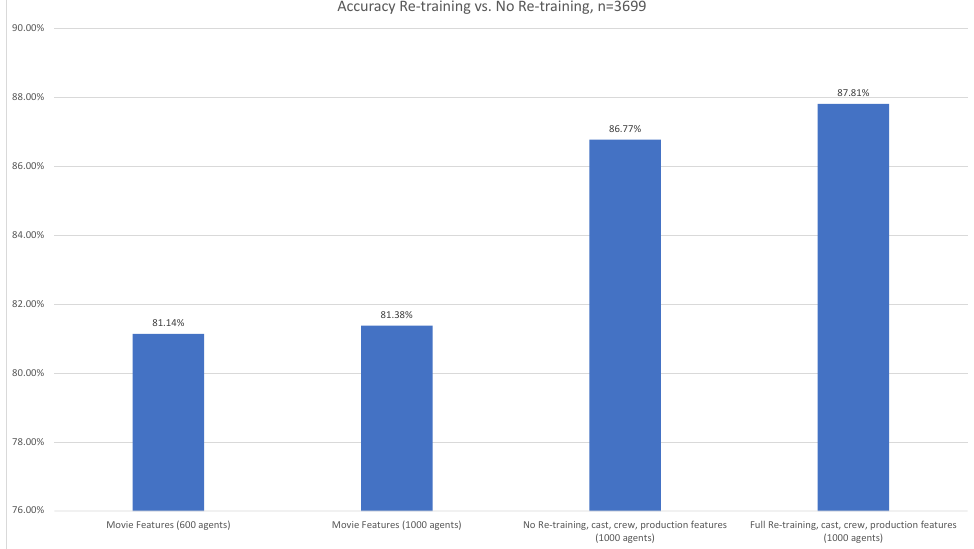
Figure 7. Cast, Crew, Production Features—System